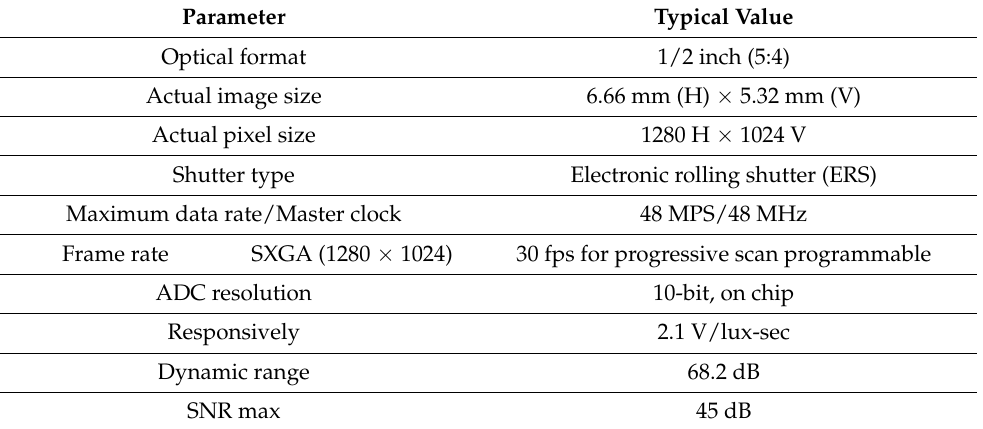
Table 1. Key parameter of CMOS